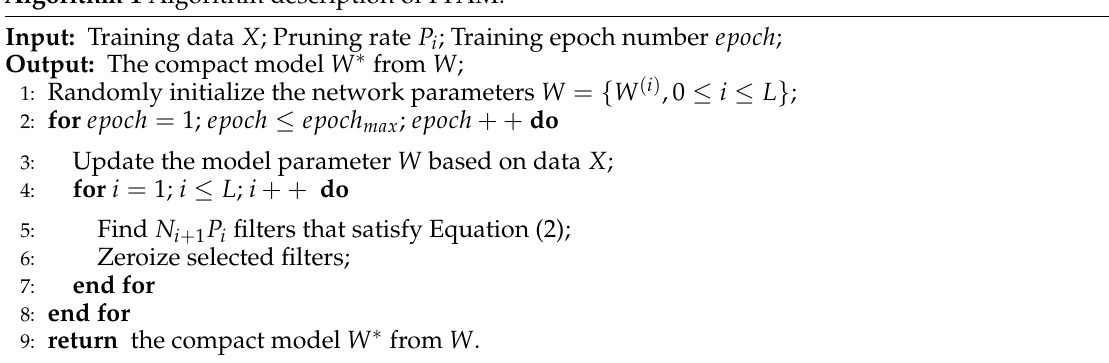
Algorithm 1 Algorithm description of